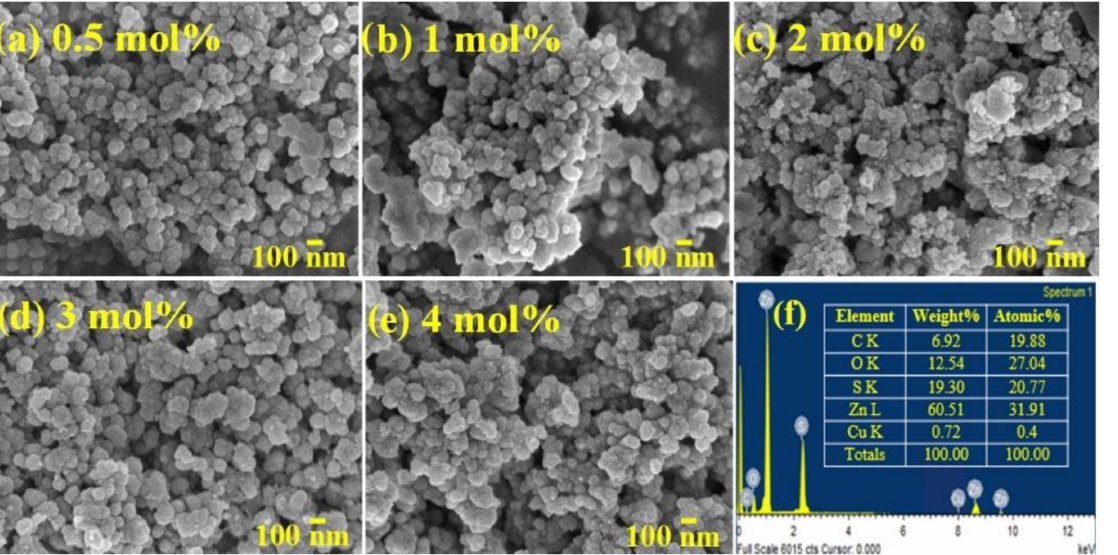
Figure 4. FE-SEM images of Cu/ZnS/COF composite photocatalyst doped with different Cu ratios: ( a ) 0.5Cu/ZnS/0.5COF, ( b ) 1Cu/ZnS/0.5COF, ( c ) 2Cu/ZnS/0.5COF, ( d ) 3Cu/ZnS/0.5COF, ( e ) 4Cu/ZnS/0.5COF. ( f ) EDX of